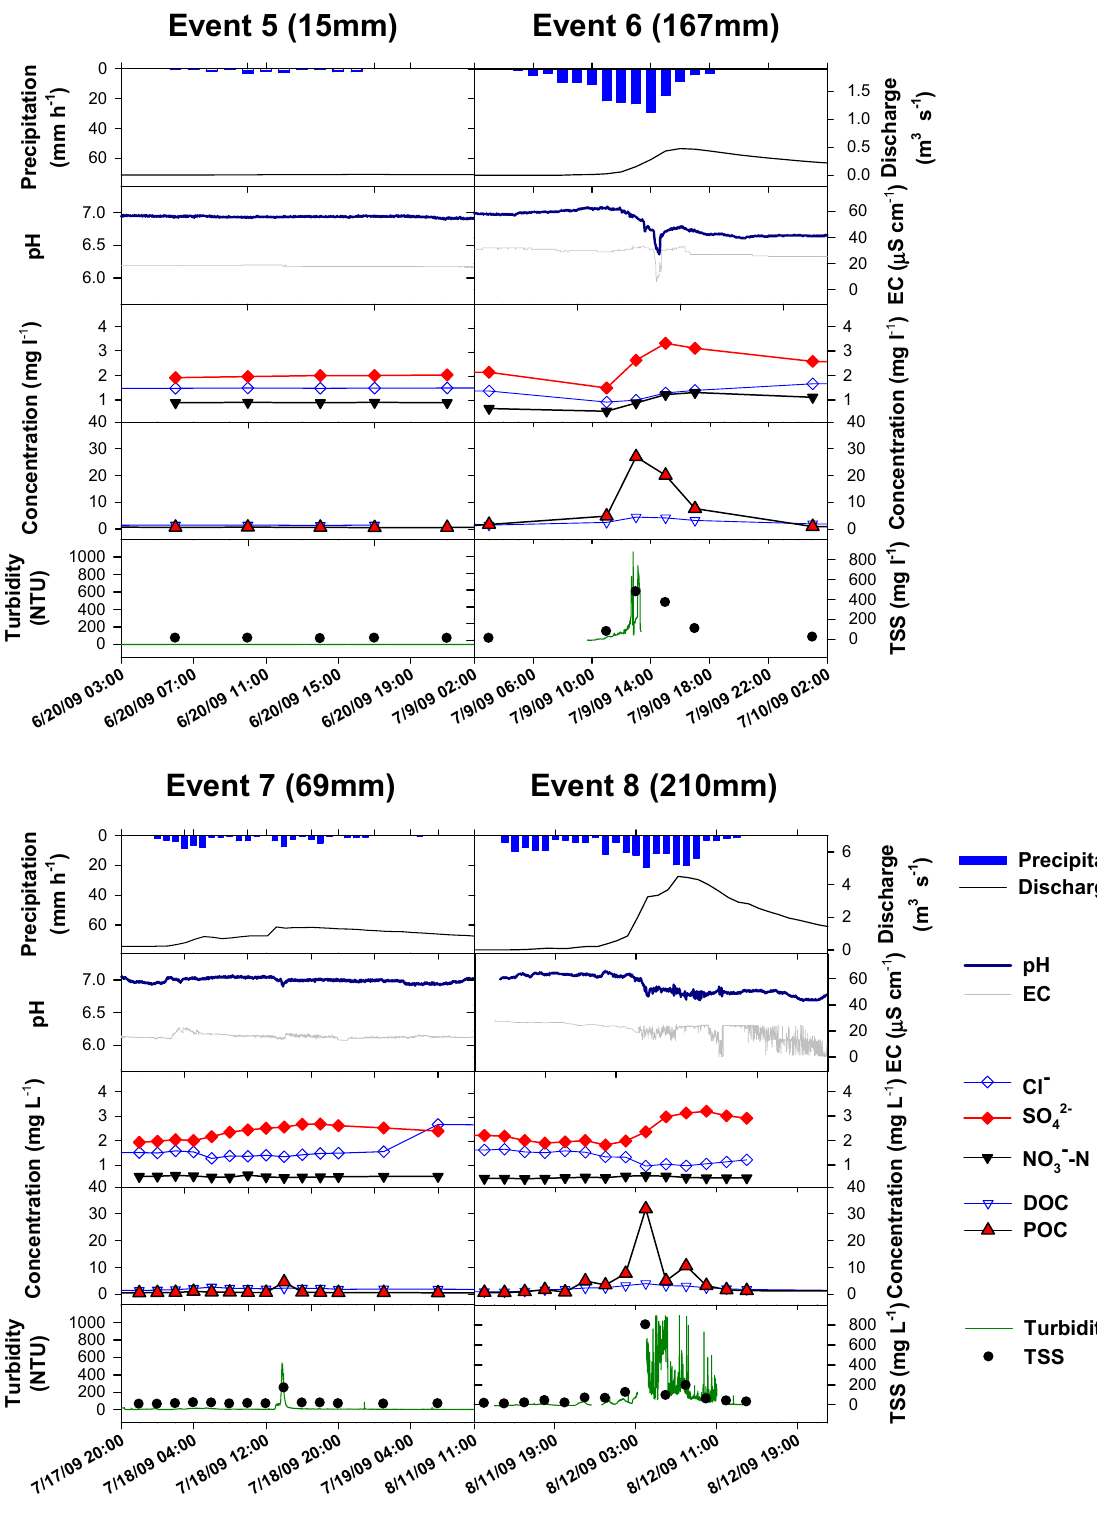
Figure 4. Temporal variations in hourly precipitation (mm), discharge (m 3 ·s − 1 ), pH, EC ( μ S·cm − 1 ), concentrations (mg·L − 1 ) of dissolved ions, DOC, and POC, turbidity (NTU) and TSS concentration (mg·L − 1 ) during four rainfall events in 2009. DOC and POC data of Event 8 have been published in a previous report